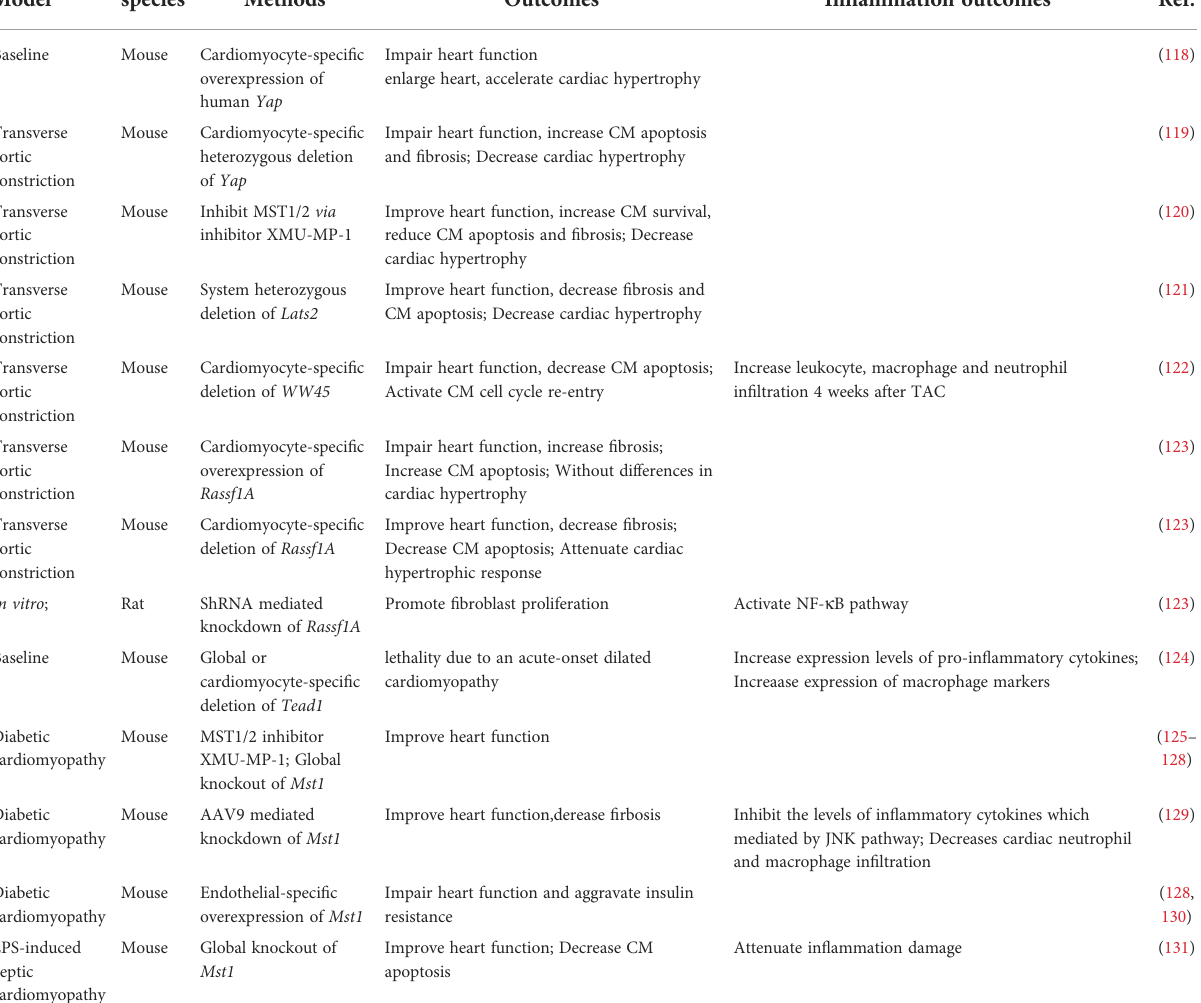
TABLE 2 Hippo-YAP pathway and in fl ammation in heart failure and cardiomyopathy.